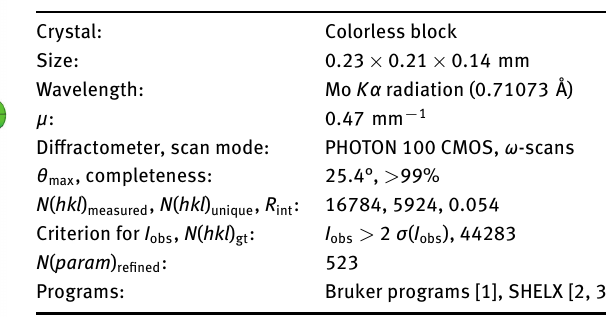
Table 1: Data collection and handling.